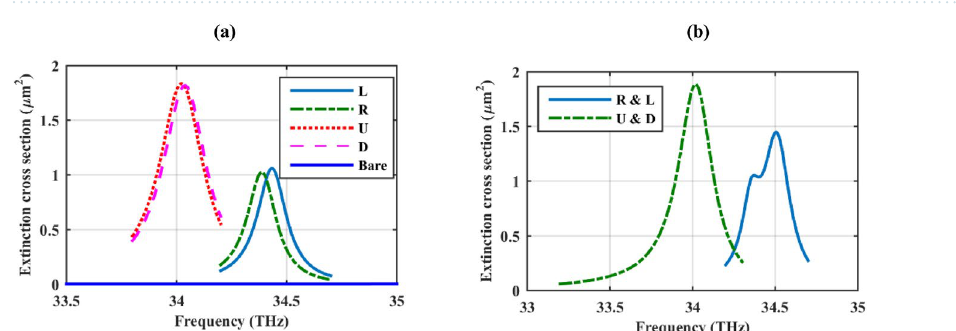
Figure 2. The extinction cross-section of the structure in Fig. 1 and its comparison with the bare cylinder. In ( a ) only one and in ( b ) double one-dimensional periodic arrays of nanoparticles are considered at the specified locations in Fig. 1. The design parameters are as follows: r c = 500 nm, ε c = 2, r s = 100 nm, h = 250 nm τ = 1.5 ps, and μ c = 0.5 eV. The spherical particles are considered